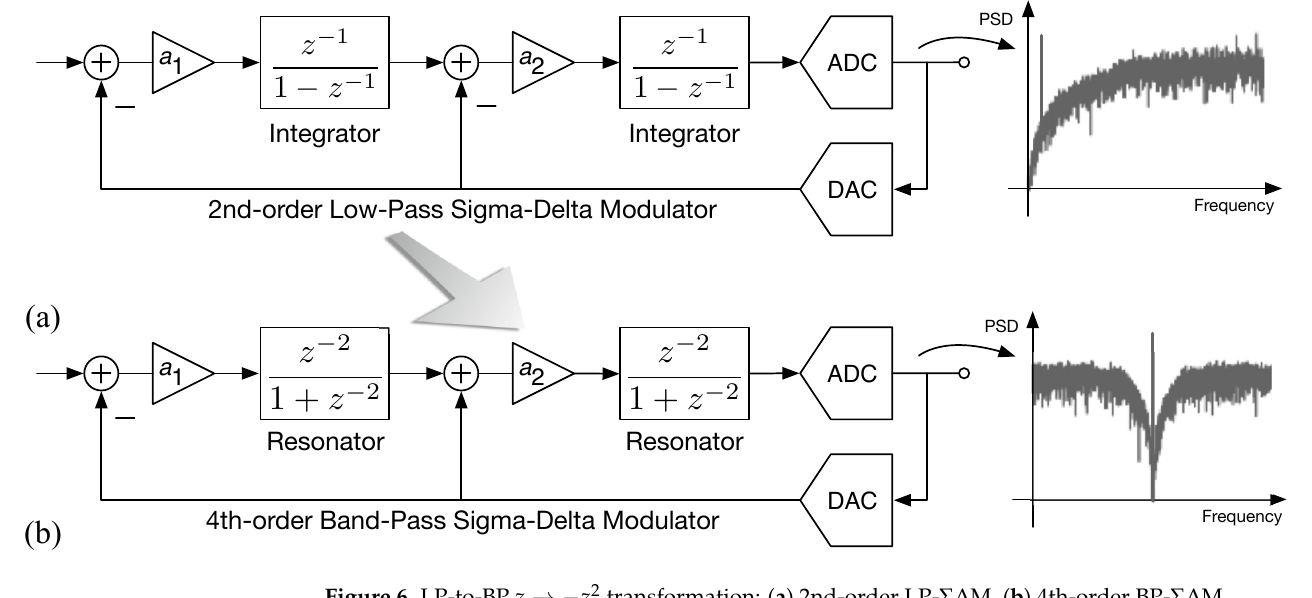
z 2 transformation: ( a ) 2nd-order LP- Σ∆ M, ( b ) 4th-order BP- Σ∆ M. Figure 6. LP-to-BP z → − z 2 transformation also allows to place the input signal at 3 f s /4 [40] The z → −